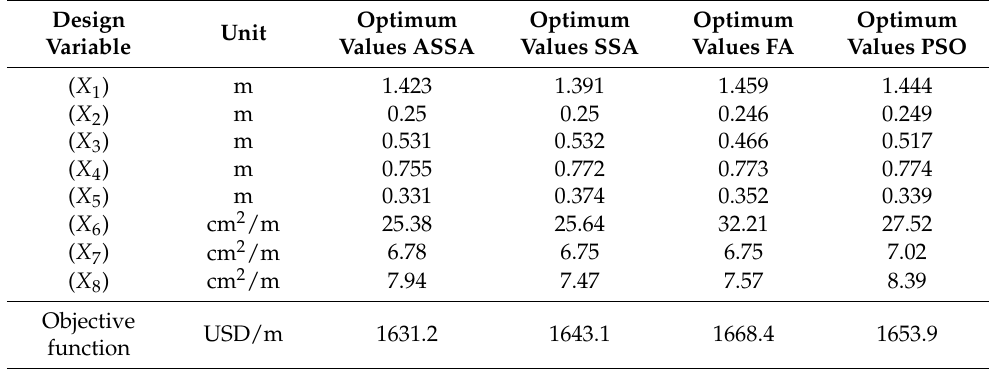
Table 19. Optimization results for design example